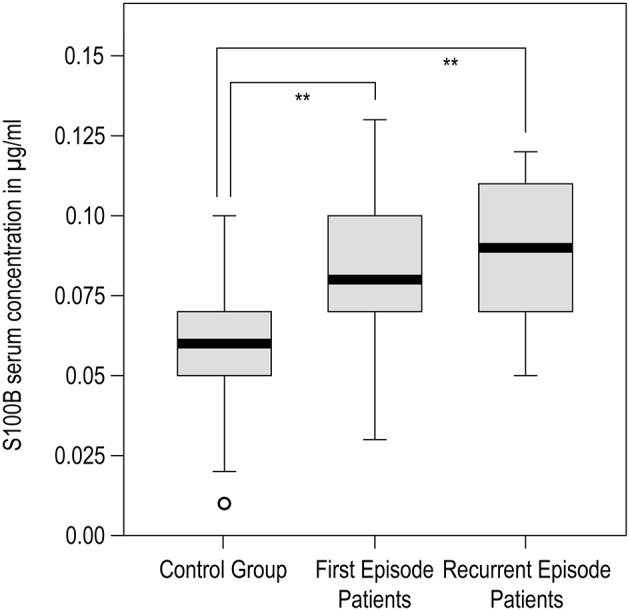
SPSS generated boxplot for results of S100B serum concentration analysis. Black bar within box: median, gray box: 25–75% quartiles; small black bars: minimum to maximum; circles: outliners. Significant group differences are marked with **p < 0.01.